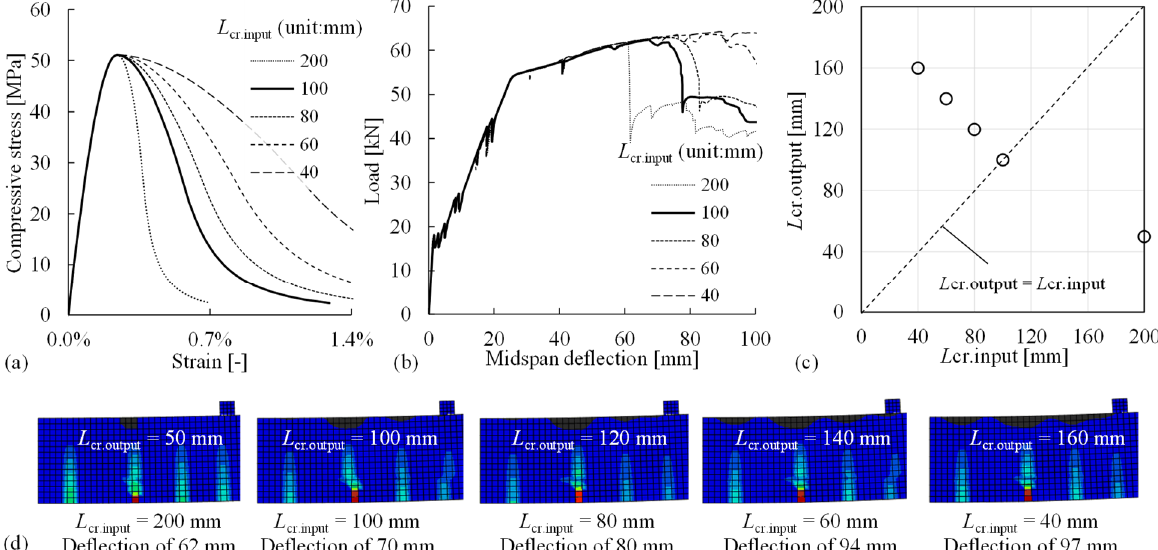
Figure 16. ( a ) Concrete compressive behavior based on the Model Code relation with the modified post-peak strain-softening branches given different L cr.input values ranging from 40–200 mm; ( b ) simulated load–deflection relations corresponding to each value of L cr.input ; ( c ) comparison of the assumed L cr.input and the observed size of the critical crushing zone L cr.output for each FE analysis (represented by a circle); ( d ) contour plot of the beam models within the constant-moment region for visualizing the crushing zones and evaluating L cr.output given different values of L cr.input .